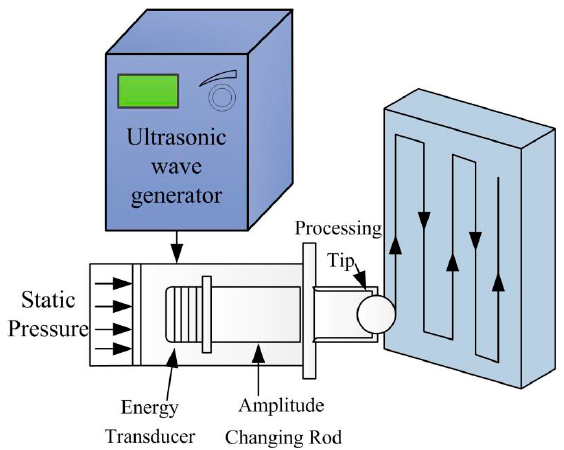
Figure 1. Schematic procedure of the ultrasonic impacting and rolling process (UIRP).